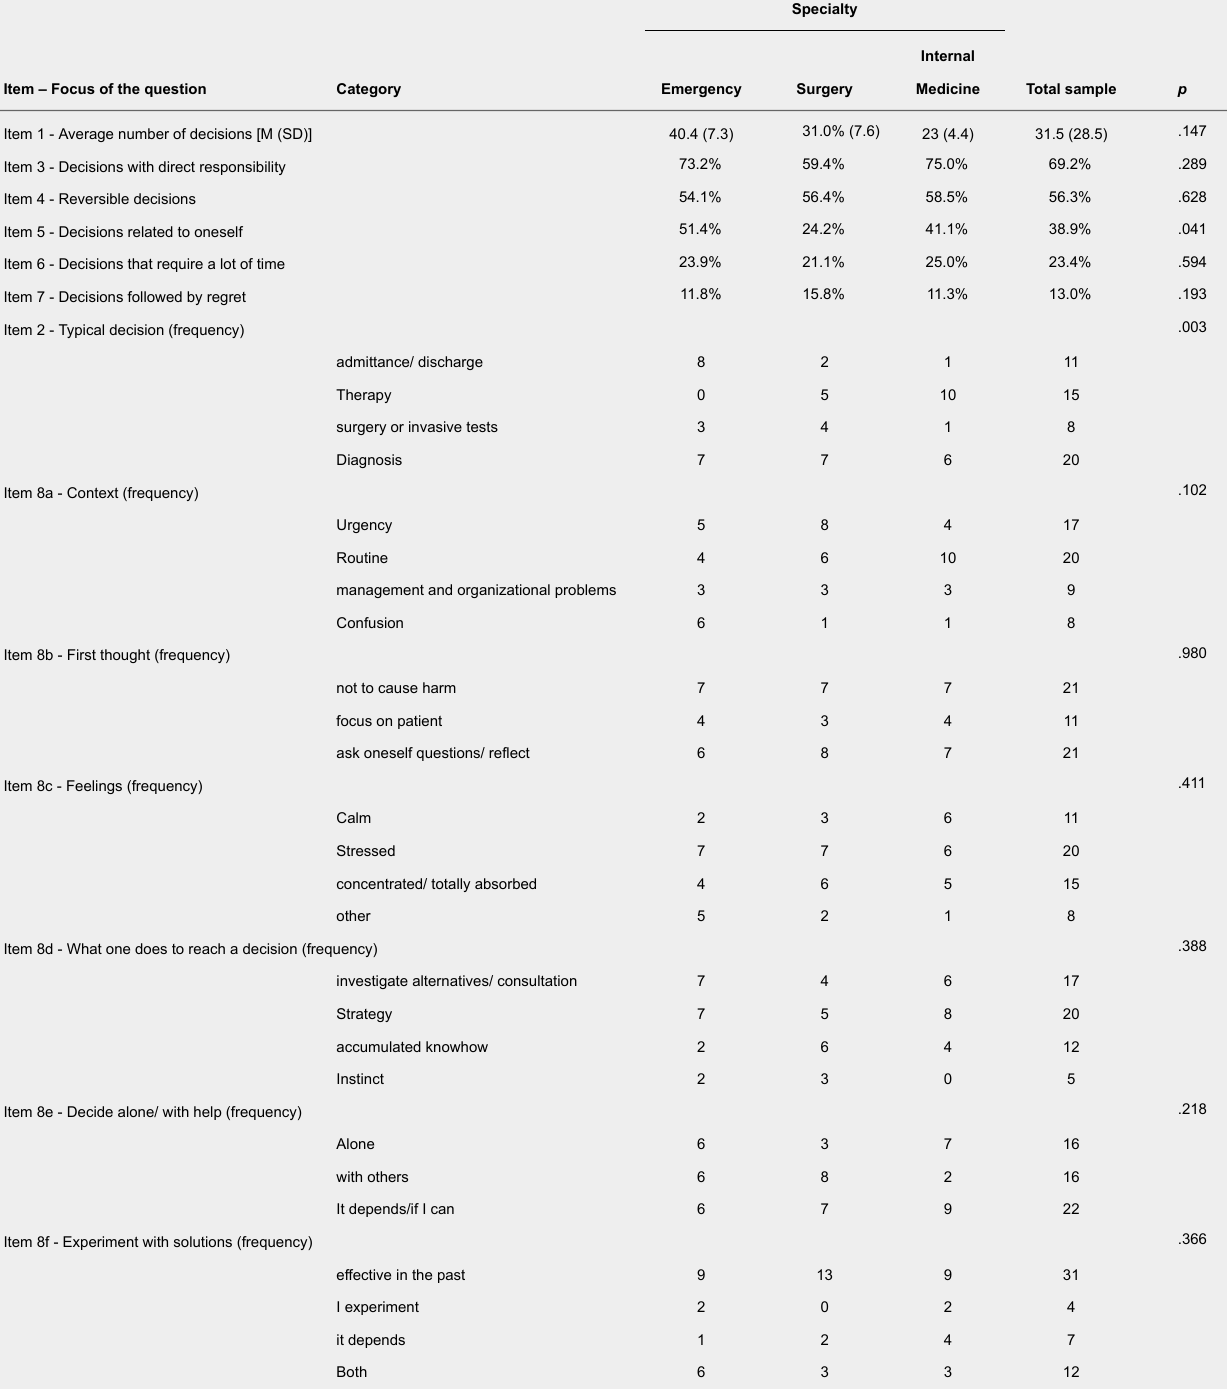
Responses to Questions in the First Part of the Questionnaire According to Specialty